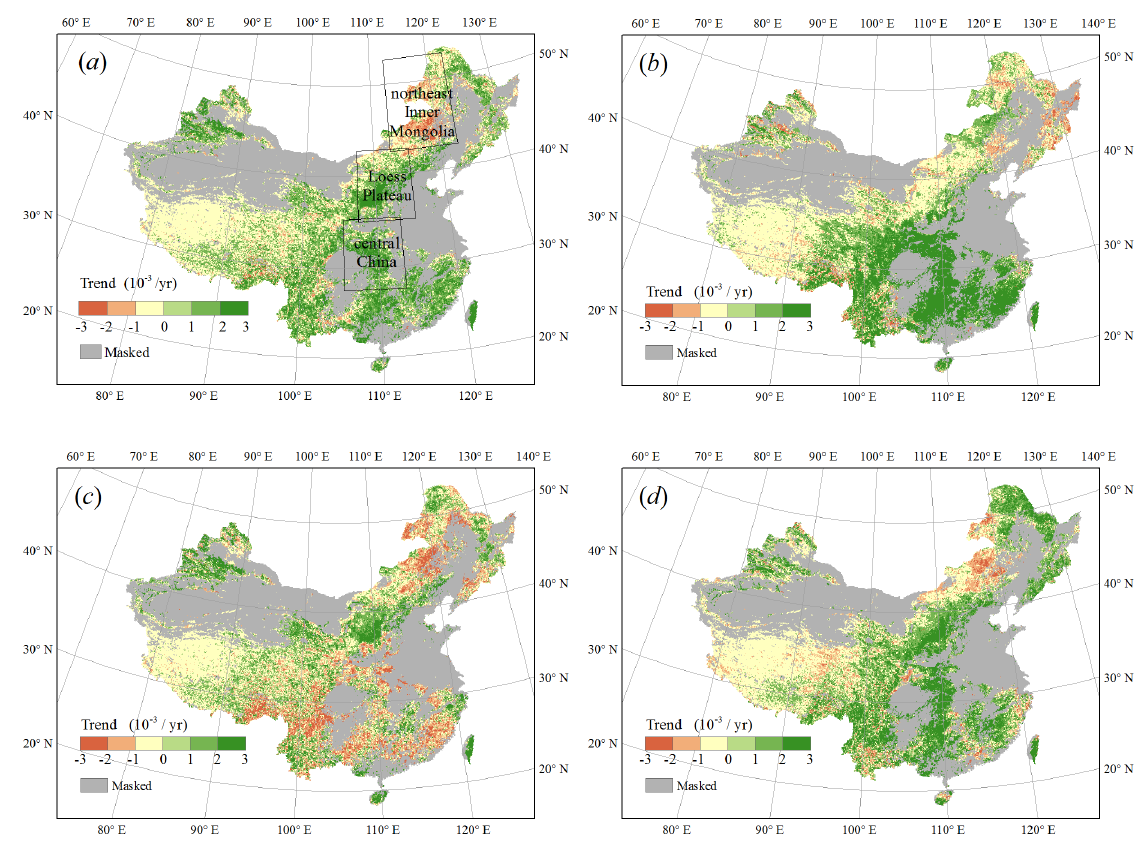
Figure 6. Spatial patterns of NDVI trends in ( a ) growing season; ( b ) spring; ( c ) summer and ( d ) autumn over the period of